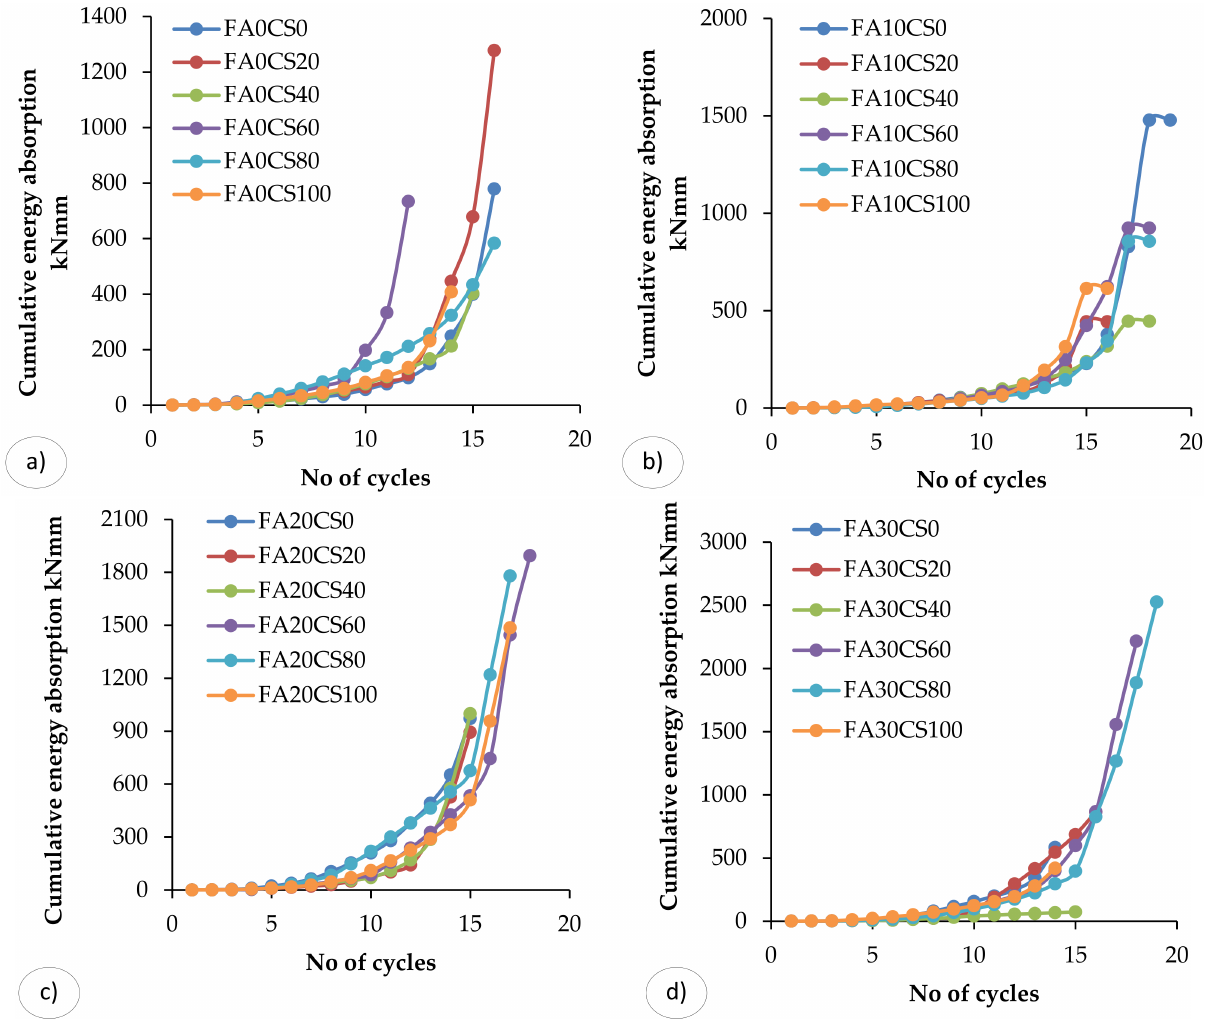
Figure 10. Cumulative energy absorption versus no. of cycles: ( a ) 0%FA and 0–100%CS, ( b ) 10%FA and 0–100%CS, ( c ) 20%FA and 0–100%CS, ( d ) 30%FA and